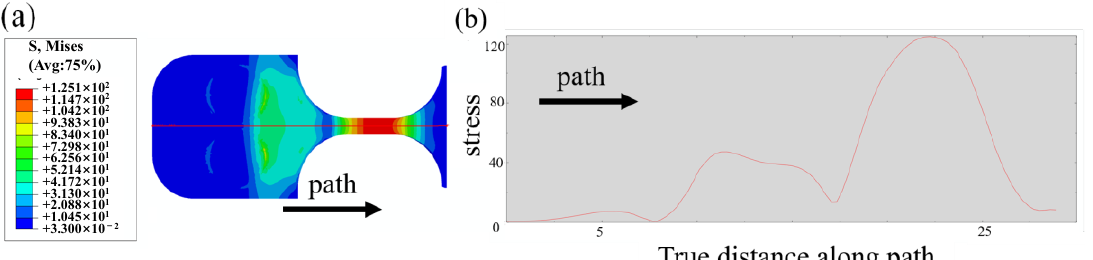
Figure 3. Stress amplitude along the axial of the sample. ( a ) Schematic diagram of uniaxial resonance stress path; ( b ) stress amplitude along the path with 1 µm given displacement.